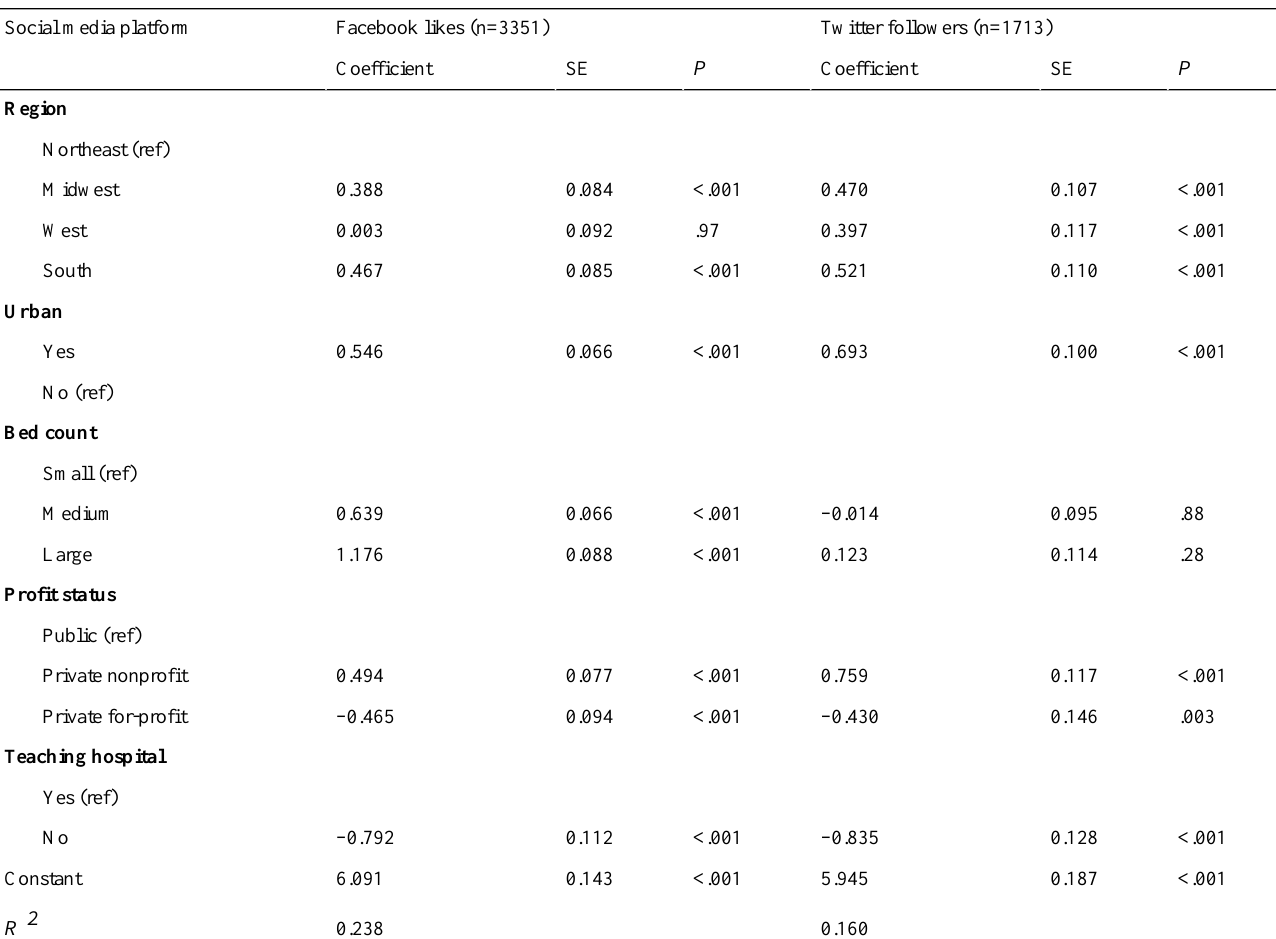
Table 3. Ordinary least squares regression of social media utilization relative to hospital characteristics: Facebook and